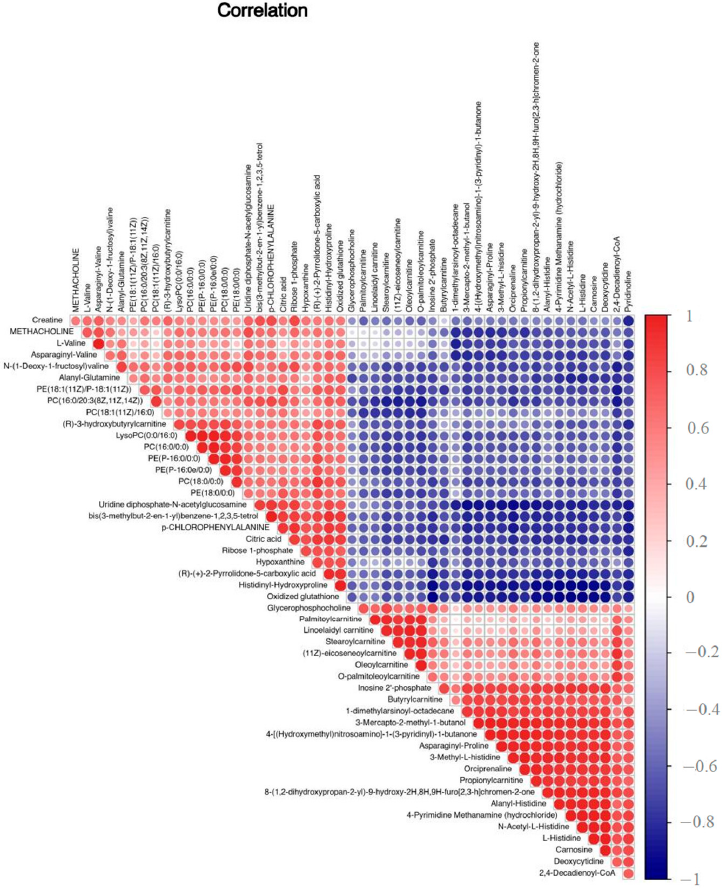
Figure 4. Correlation analysis chart of differential metabolites (Top50).